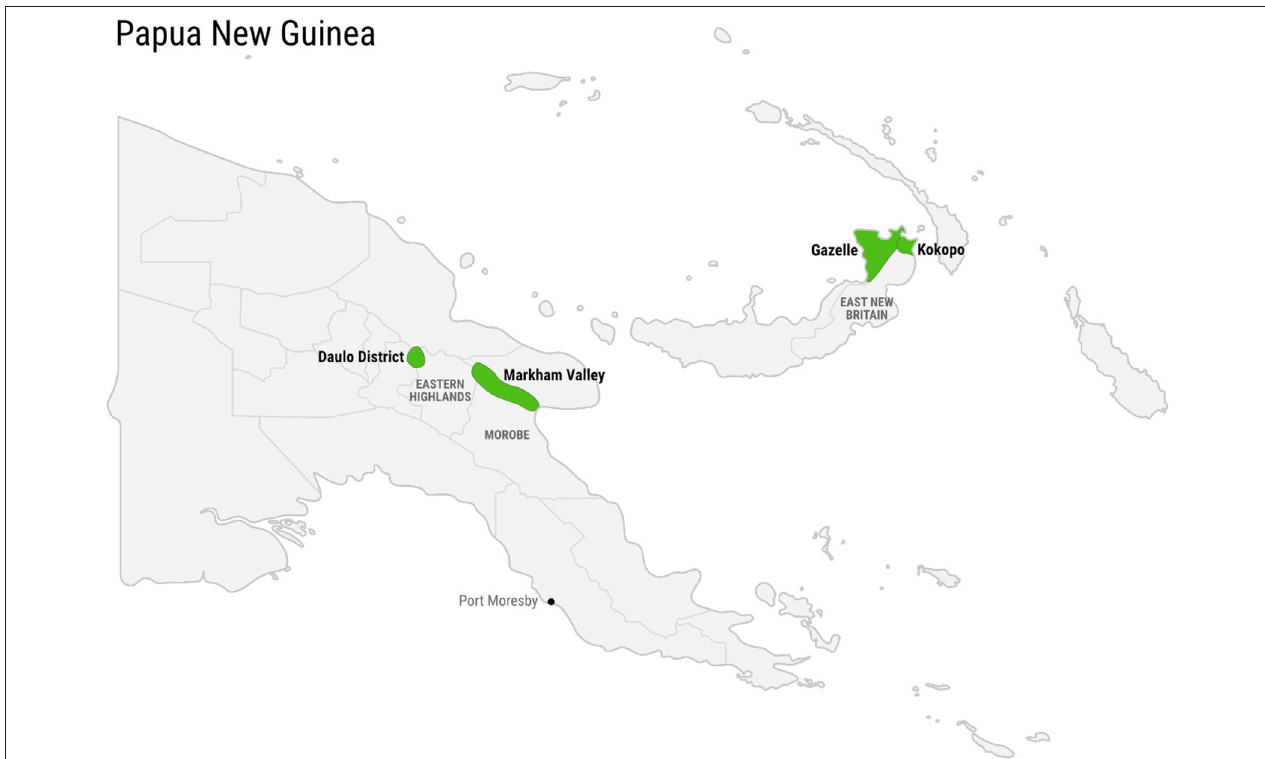
FIGURE 1 | Map of study provinces in Papua New